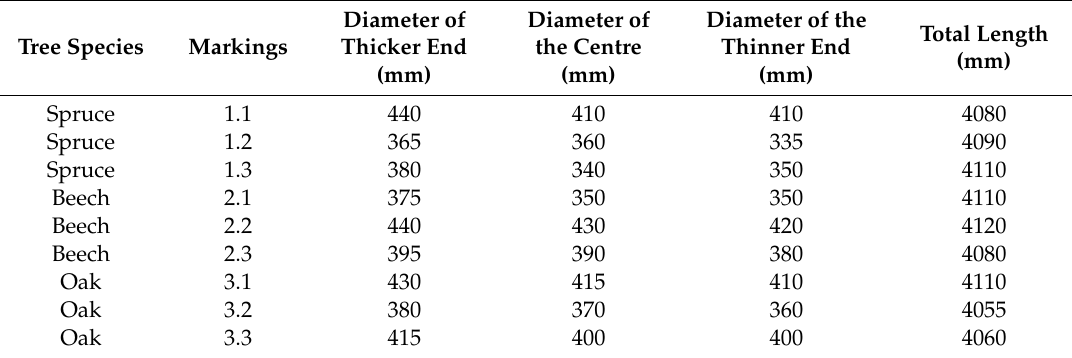
Table 1. Parameters of logs